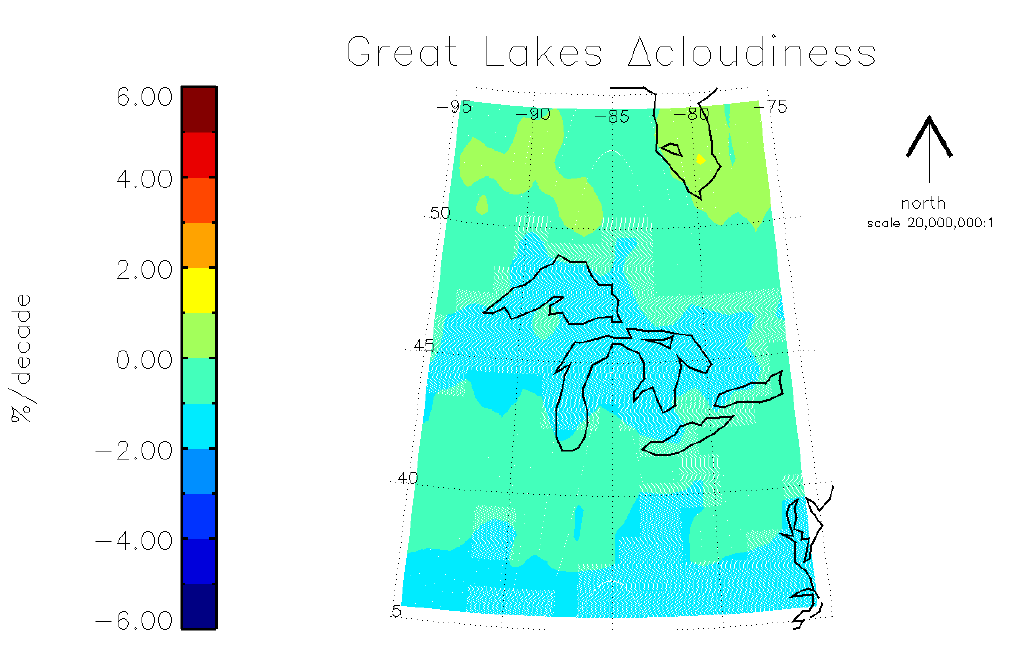
Figure 3. The trends in cloud cover change over the region during the period 1982 and 2002. The white stippled areas indicate regions where the trend is significant according the [9,10] statistical test.